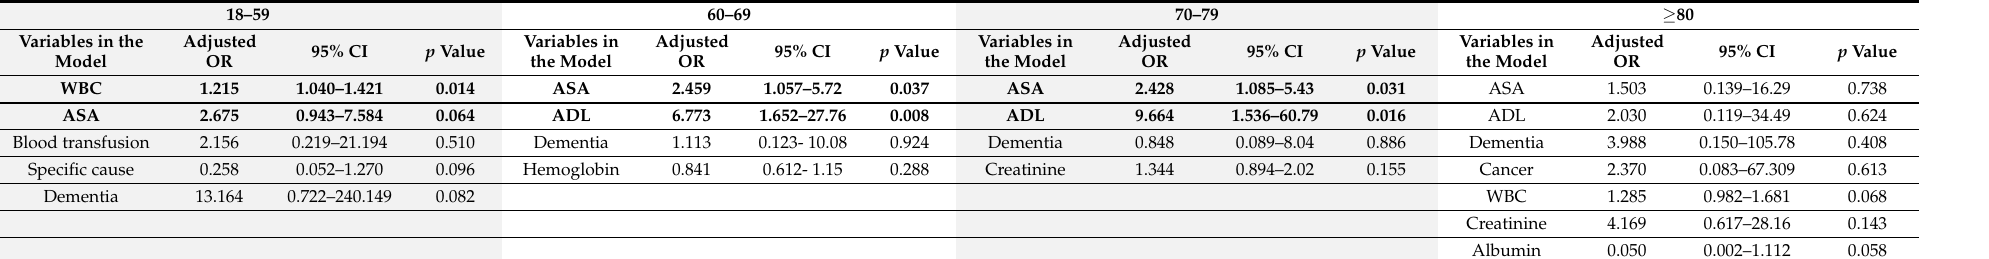
Table 3. Multivariable regression analysis for risk-factors for 30-day